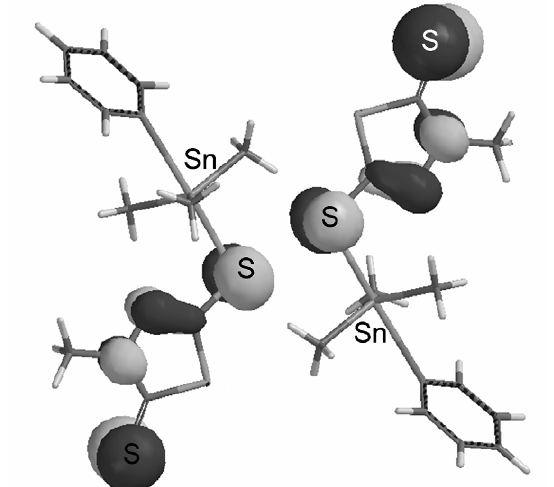
Figure 4. HOMO orbital of the system shown in Fig. 2 (BP86/6- 31G**, single-point calculation on crystal structure